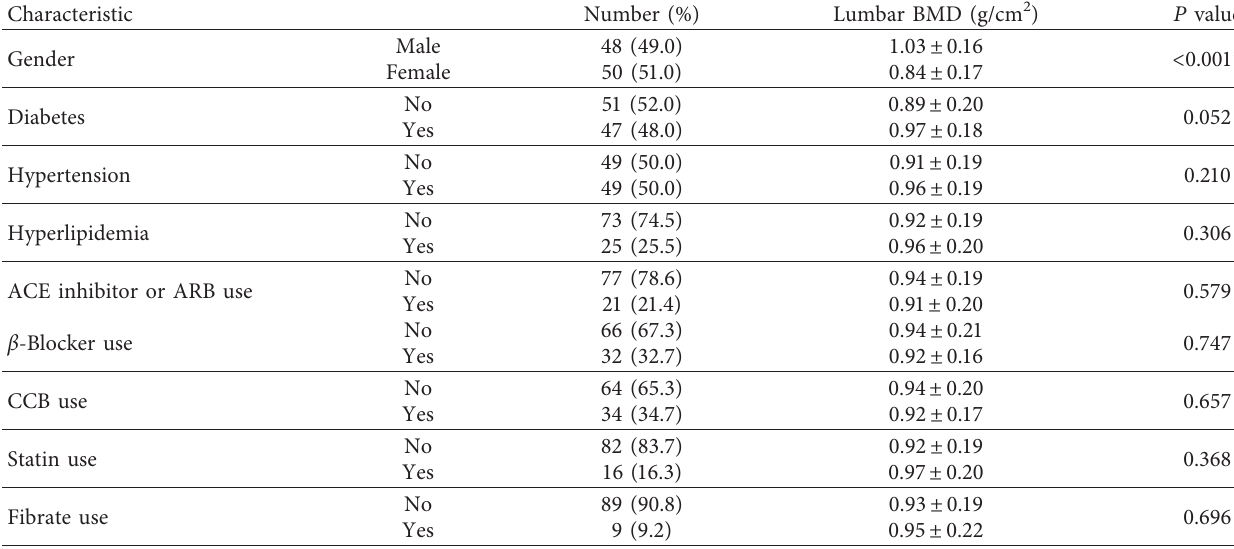
Table 2: Clinical characteristics with gender, comorbidity, drugs used, and lumbar bone mineral density levels among hemodialysis